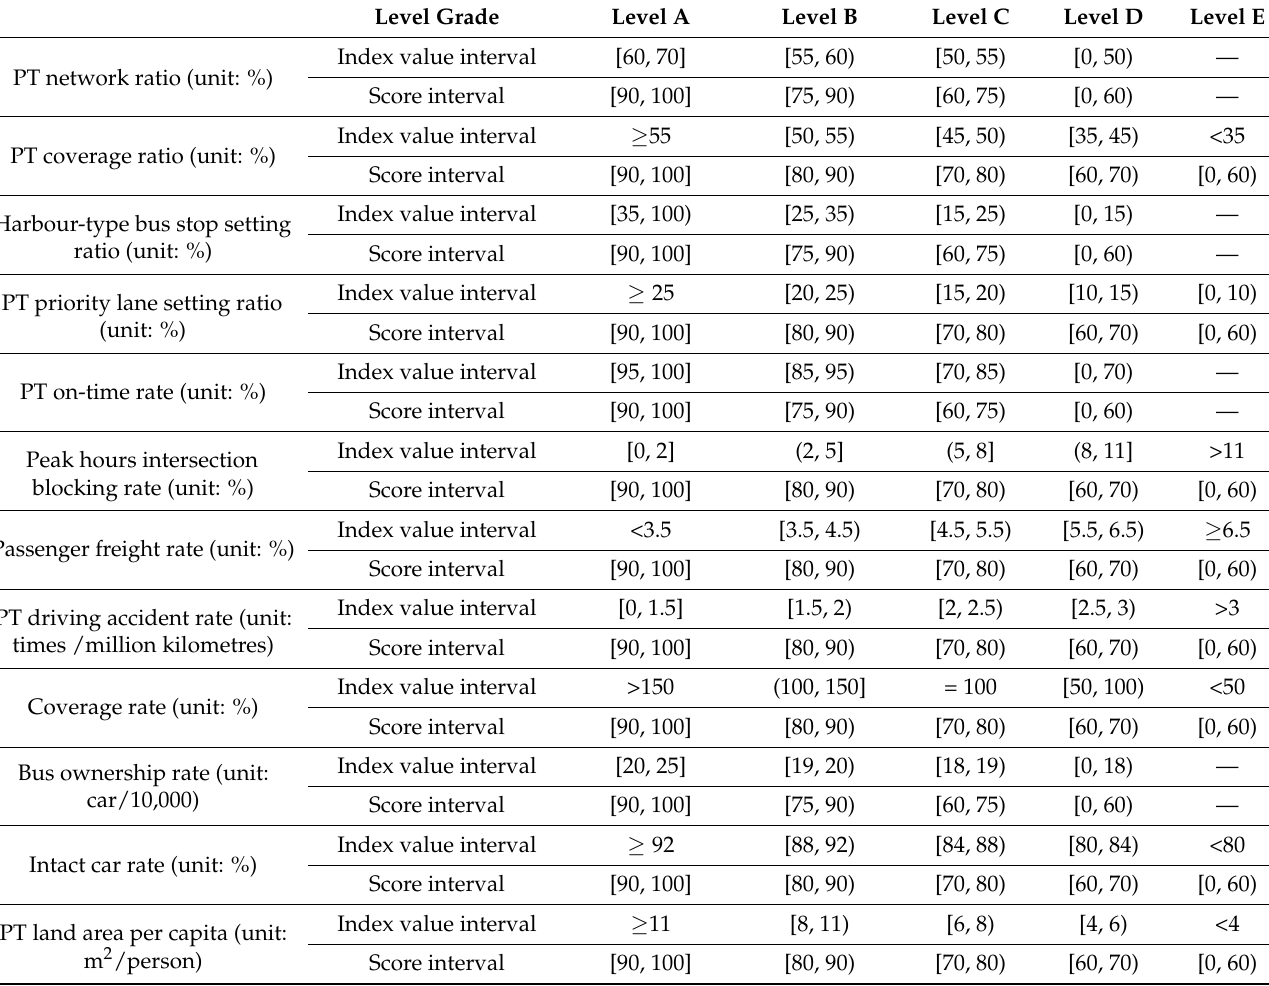
Table A2. Level grade for all sub-criteria